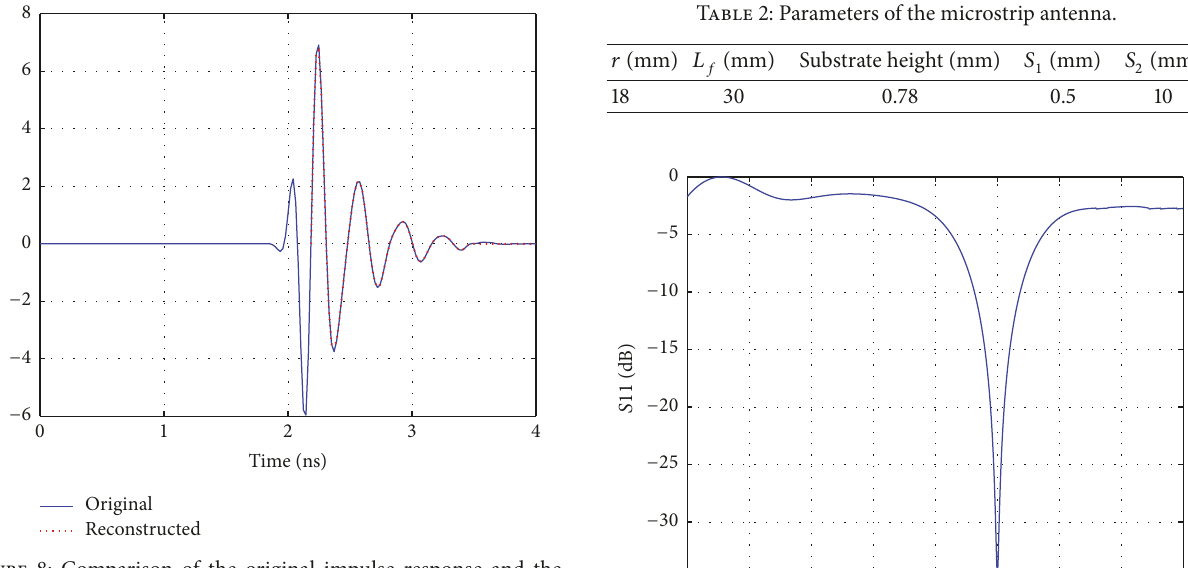
Figure 8: Comparison of the original impulse response and the reconstructed response of the wire-monopole antenna.